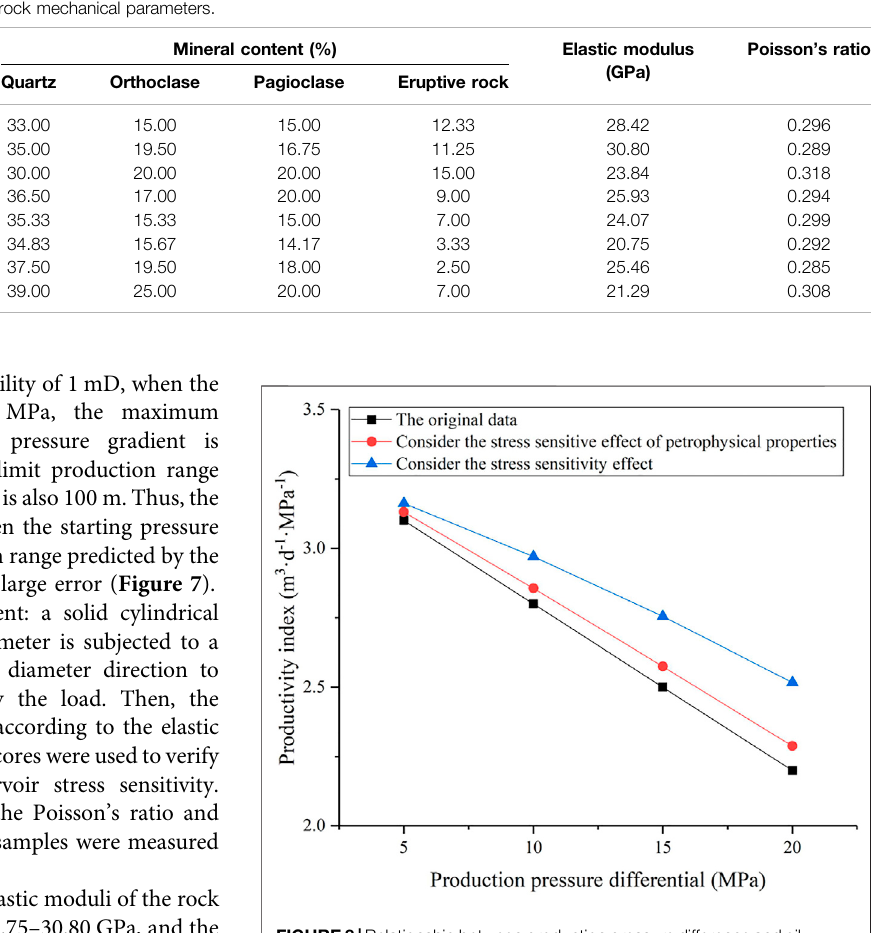
FIGURE8| Relationshipbetweenproductionpressuredifferenceandoil recovery index.